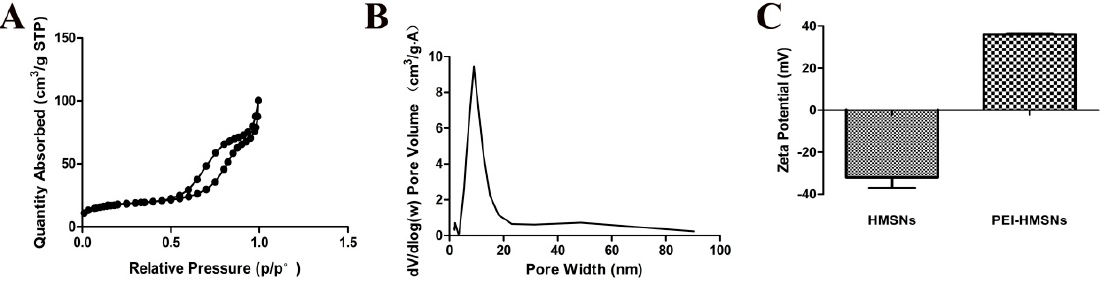
Figure 2. Characterization of porous structure and surface charge. ( A ): Nitrogen adsorption/desorption isotherms of HMSNs; ( B ): Pore size distribution in HMSNs; ( C ): Zeta potentials of HMSNs and PEI-HMSNs.